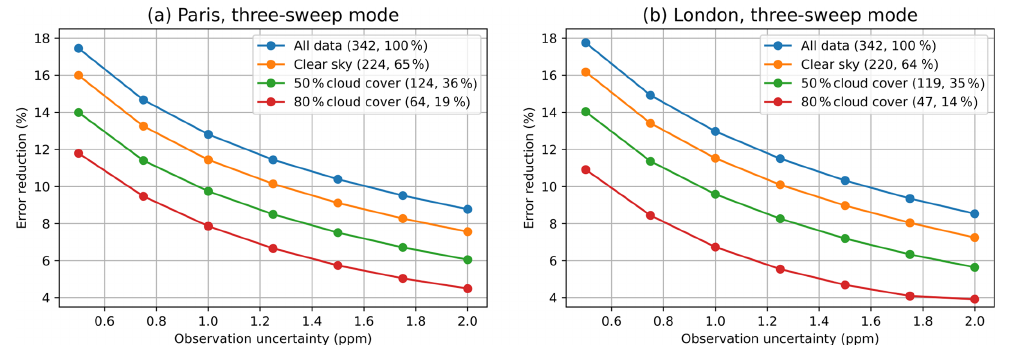
Figure 6. Spatially averaged flux error reduction with the change of observation uncertainty under different sampling scenarios in Paris (a) and London (b) . Numbers in parentheses are the number of observations and the percentage relative to the total number of observations for the three-sweep mode (342).